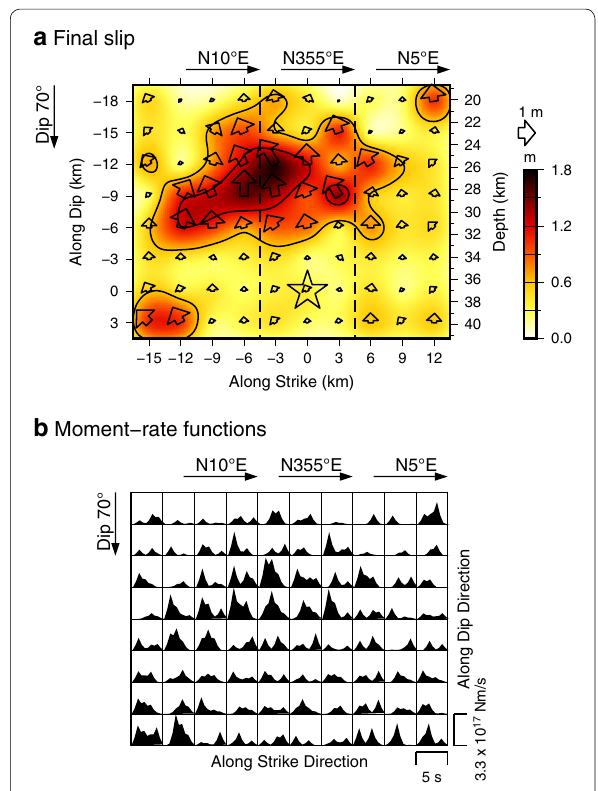
Fig. 5 Source model of the 2018 Hokkaido Eastern Iburi earthquake. a Spatial distribution of the final slips on the assumed fault plane with a contour interval of 0.6 m. The arrow shows the slip vector of the hanging wall relative to the foot wall. The open star indicates the hypocenter or the rupture starting point. Dashed lines represent the boundaries of fault segments. b Obtained moment rate functions